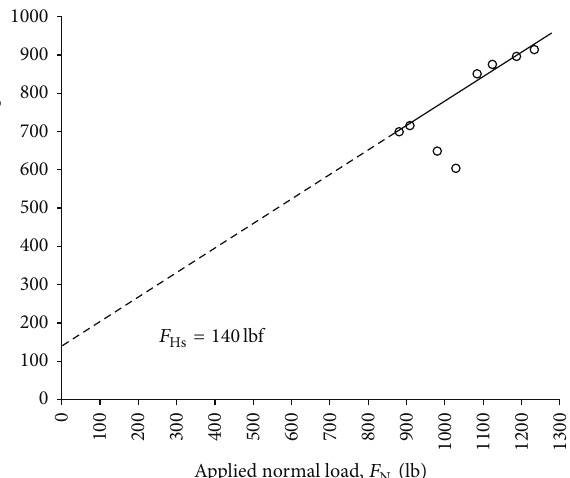
Figure 12: Dry Belcher Road test results.